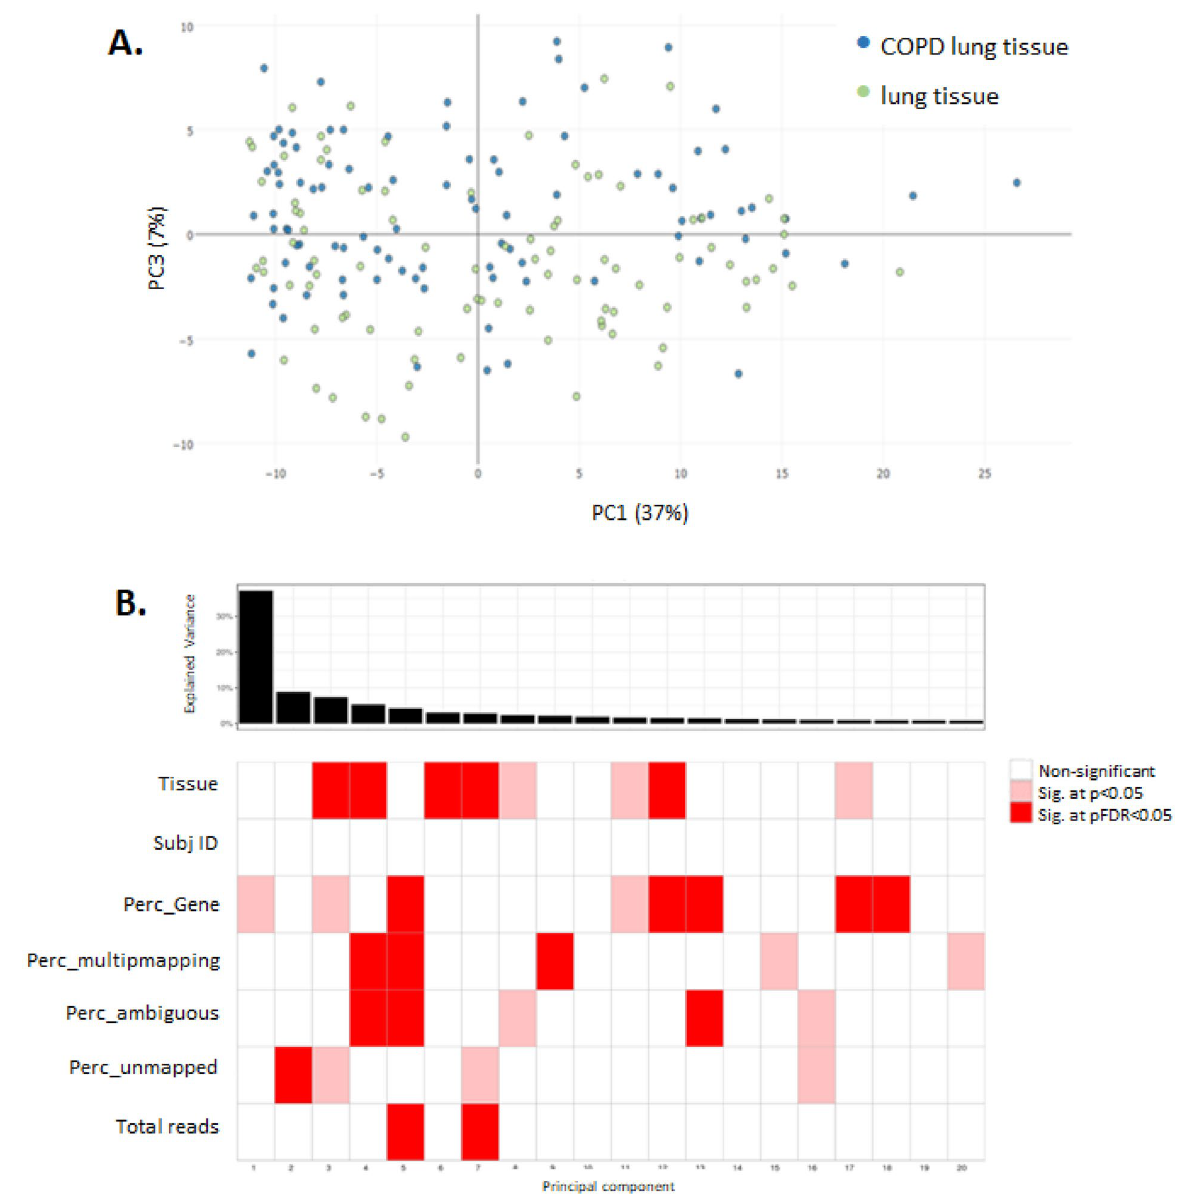
gene. These are used in the differential expression analysis. Perc_multimapping Percentage of read-pairs mapped to more than one location in the genome. Perc_unmapped Percentage of read-pairs not mapped to any location in the